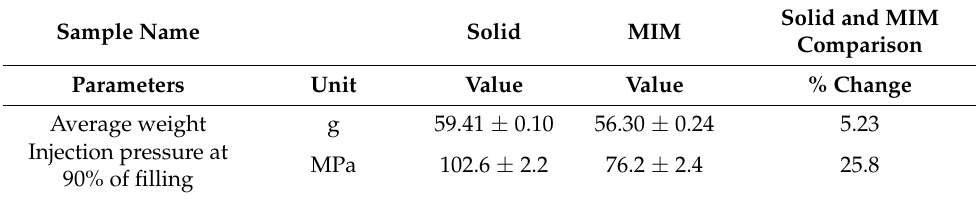
Figure 9. ( Left ) solid and ( right ) MIM box-shaped parts. Table 3. Injection pressure and weight